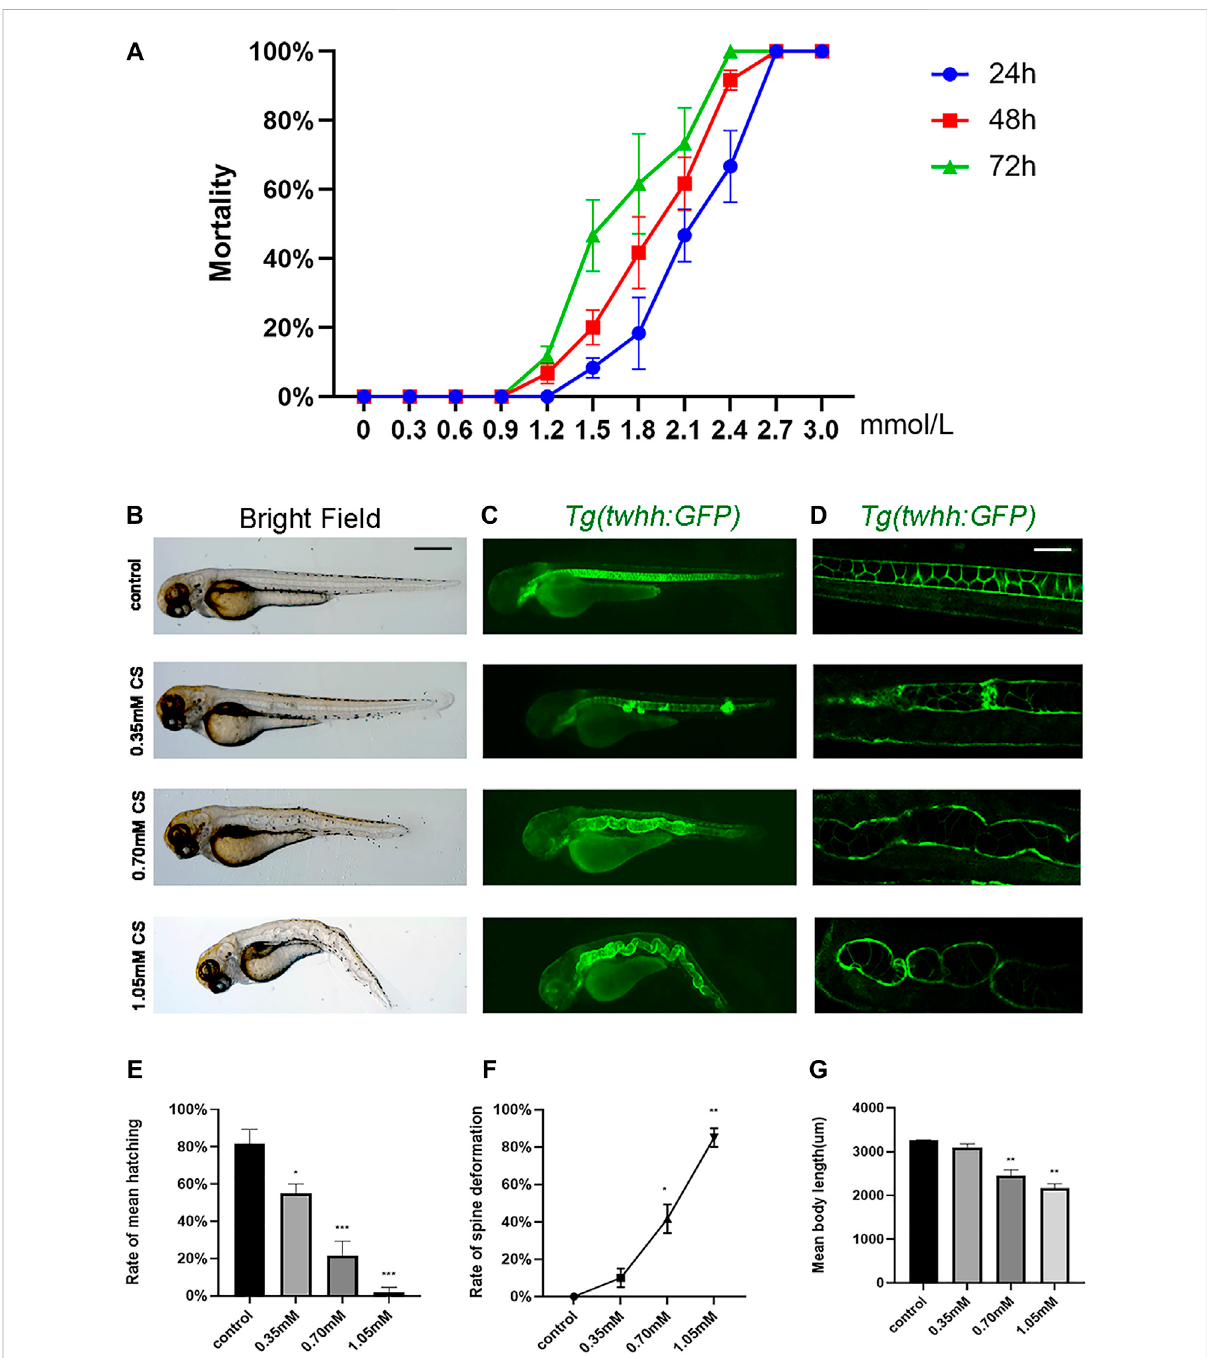
FIGURE 1 The phenotype of skeletal development defects in embryos after cysteamine exposure. (A) The cumulative mortality rate of zebra fi sh exposed from0to3.0 mMcysteamineat24,48and72hpf. (B – D) MicroscopicimagingofTg(twhh:GFP)zebra fi shlarvaeexposedto0.35,0.70,and1.05 mM cysteamine at 72 hpf. (E) The hatching rate of zebra fi sh exposed to 0.35, 0.70, and 1.05 mM cysteamine at 72 hpf. (F) The deformation rate of zebra fi sh exposed to 0.35, 0.70, and 1.05 mM cysteamine at72 hpf. (G) The body length of zebra fi sh larvae exposed to 0.35, 0.70, and 1.05